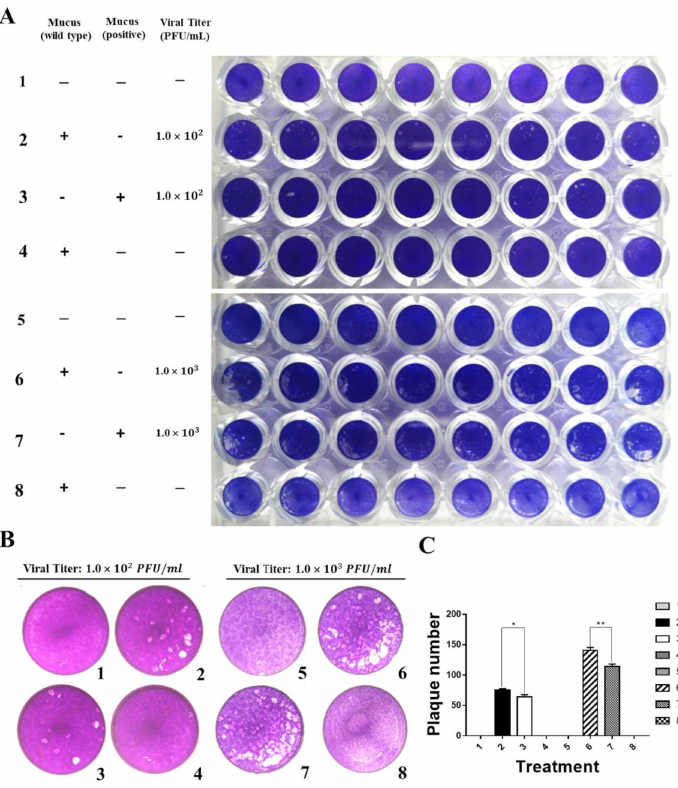
Figure 5. Grass carp IFN1 from mucus inhibited the plaque formation of cultured cells infected with GCRV873. ( A , B ) Detection of the antiviral ability of grass carp IFN1 from the mucus of transgenic loach. 1, 5: added M199 medium containing 2% FBS; 2: added M199 medium containing 2% FBS and 20% mucus ( v / v ) from wide type (WT) loaches and infected with GCRV873 (viral titer: 1.0 × 10 2 PFU/mL); 3: added M199 medium containing 2% FBS and 20% mucus ( v / v ) from grass carp IFN1-expressing transgenic loaches and infected with GCRV873 (viral titer: 1.0 × 10 2 PFU/mL); 6: added M199 medium containing 2% FBS and 20% mucus ( v / v ) from WT loaches and infected with GCRV873 (viral titer: 1.0 × 10 2 PFU/mL); 7: added M199 medium containing 2% FBS and 20% mucus ( v / v ) from grass carp IFN1-expressing transgenic loaches and infected with GCRV873 (viral titer: 1.0 × 10 3 PFU/mL); 4, 8: added M199 medium containing 2% FBS and 20% mucus ( v / v ) from WT loaches. ( C ) Graph of plaque numbers of the Figure 5A. The experiments were performed in triplicate. Data were expressed as mean ± SD. * p < 0.05; ** p < 0.01. At a viral titer of 1 × 10 2 PFU/mL, plaque numbers on plates containing IFN1 reduced by 16% when compared to those of the control. Similarly, at a viral titer of 1 × 10 3 PFU/mL, plaque numbers on plates containing mucus from transgenic loaches reduced by 18% in comparison with those of the control (Figure 5C). These results indicate that mucus of IFN1- transgenic loaches can confer a protective effect on CIK cells against GCRV873